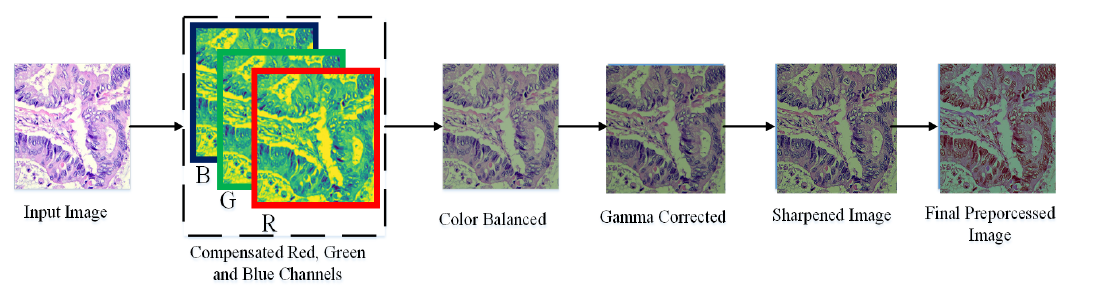
Figure 3. Image Enhancement.